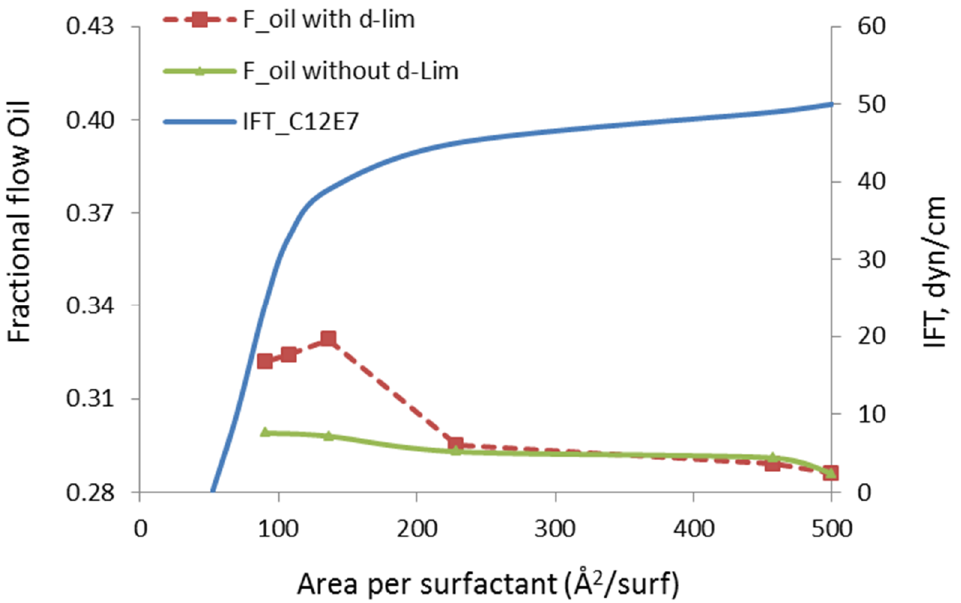
Figure 6. Fractional flow of oil (F oil ) with and without d-limonene solvent as a function of surfactant concentration at the interface.